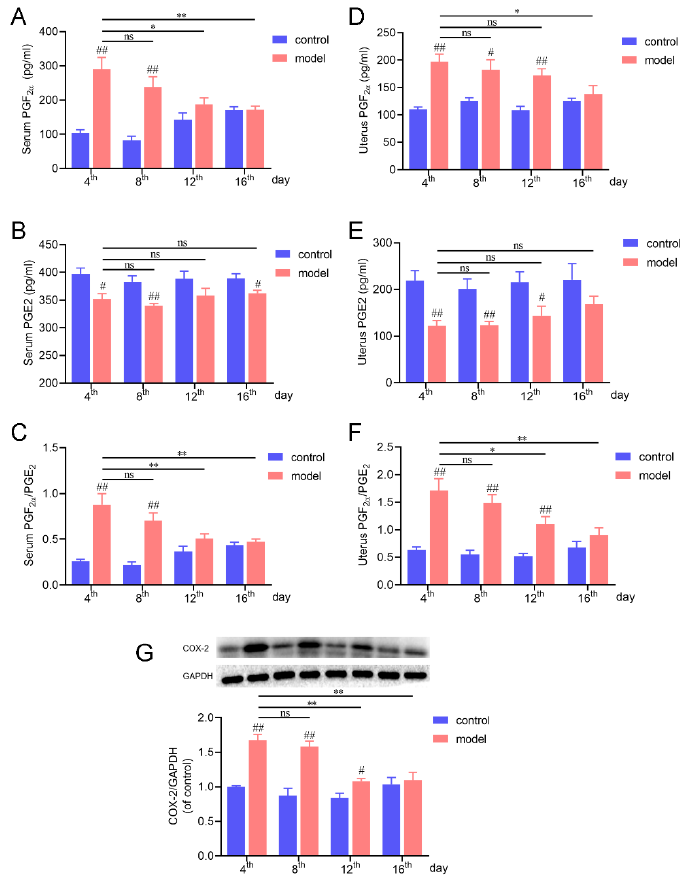
Figure 3. PD-related biochemical analysis. ( A – C ) PGF 2α , PGE 2 , and their ratio changes in serum. ( D – F ) PGF 2α , PGE 2 , and their ratio changes in uterine tissue. ( G ) COX-2 expression changes in uterine tissue during the experiment. # Model group compared with corresponding control group. # p < 0.05; ## p < 0.01; * p < 0.05; ** p < 0.01. ns, no significance (n = 6 per group). The statistical values are pre- sented in Table S1.